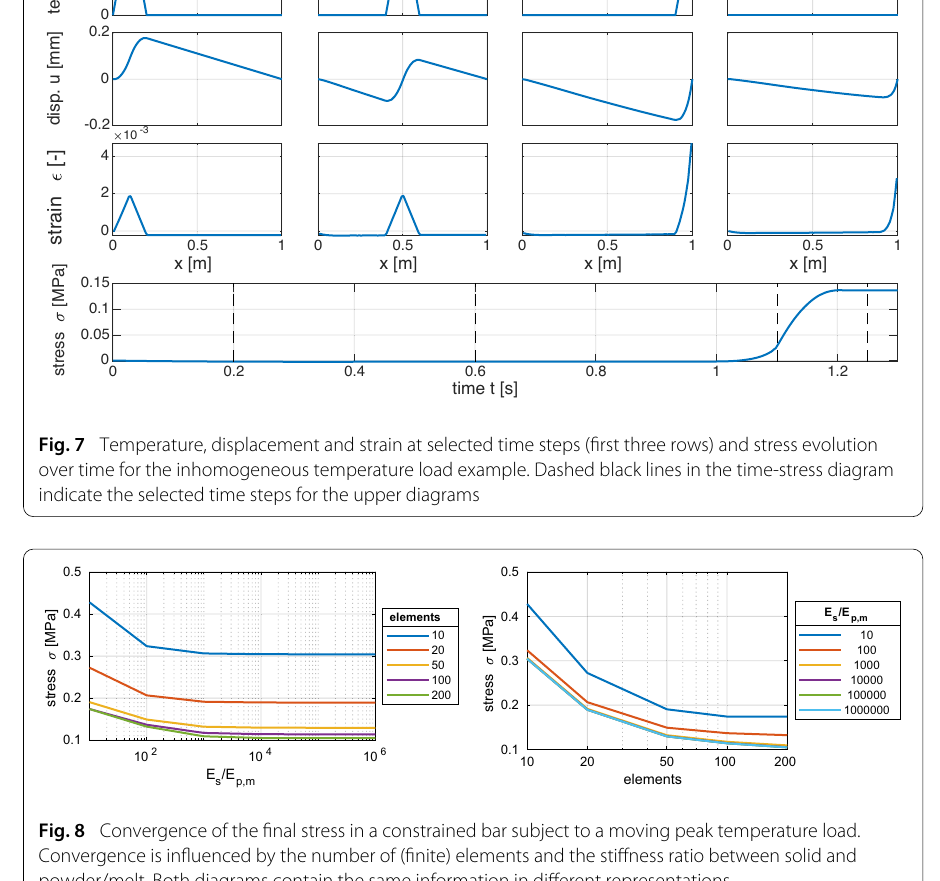
Two-dimensional domain: interaction of boundary condition and temperature